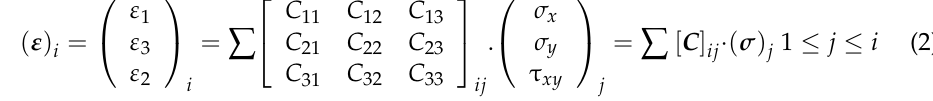
ments. Figure 2 schematically highlights the procedure of constituting the calibration co- C 1111 defines the influence of the stress σ 1 (present in the 1st increment) on the strain ε 1 . Next, the second layer is drilled. C 1121 and C 1122 , respectively, define the influences of the stress σ 1 imposed in the 1st increment and the stress vector σ 1 imposed in the 2nd incre- ment on the strain ε 1 measured. Following the same procedure for the subsequent steps, one can understand how C 1131 , C 1132 and C 1133 can be obtained.